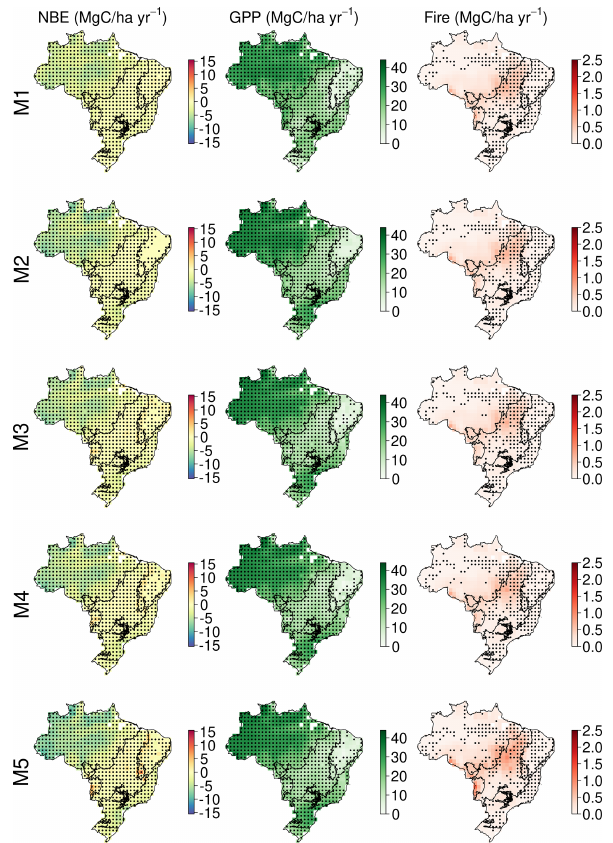
Figure 4. Comparison of DALEC model M1–5 estimated NBE and GPP with independent estimates of NEE from Carbon- Tracker Europe (2009–2017), GPP (2001–2017) from FLUX- COM/FluxSatv2/Copernicus and fire (2003–2016) GFEDv4.1s and GFAS. Stippling shows areas where the 90% confidence interval derived from DALEC analysis overlaps with the independent value.